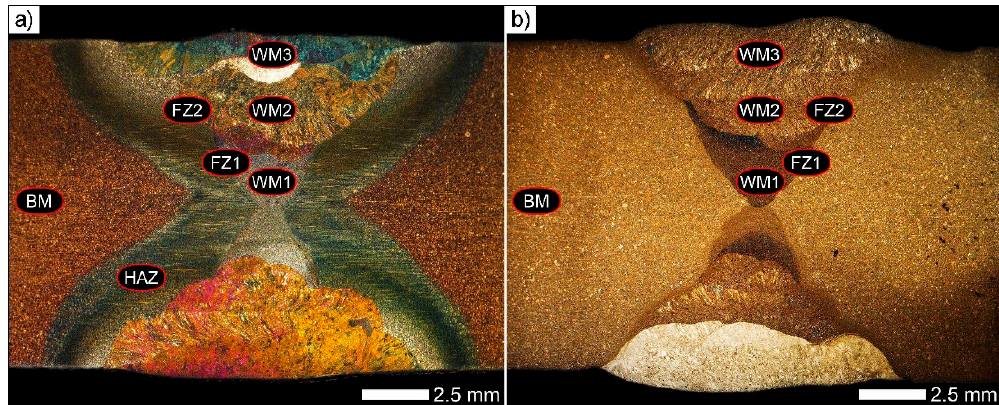
Figure 3. Macroscopic images of cross-sections of exemplary welded joints of Hardox 600: ( a ) after welding; ( b ) after heat treatment. Designations: WM1—weld metal UltraMag; WM2/WM3—weld metal OK Aristorod 89; FZ—fusion zone; HAZ—heat-affected zone, BM—base material (ca. 20 mm from the weld axis). Light microscopy, etched with 2% HNO 3 .